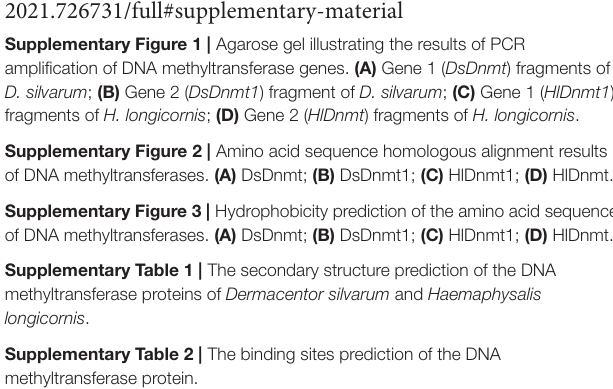
longicornis . Supplementary Table 2 | The binding sites prediction of the DNA methyltransferase